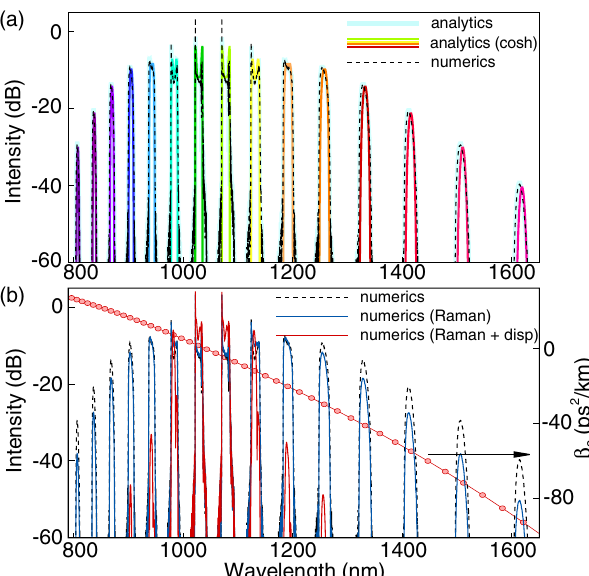
Figure 5. Parameters and results of calculations: Parameters and results of calculations for PCF SC-5.5- 1040: output spectra calculated with analytical expressions (4) (blue line), or (5) (color line), and numerically (solution of the NLSE (6)) with neglected dispersion and Raman effects ( a ) and with account for Raman and dispersion (coefficient β 2 is shown by circles) effects ( b